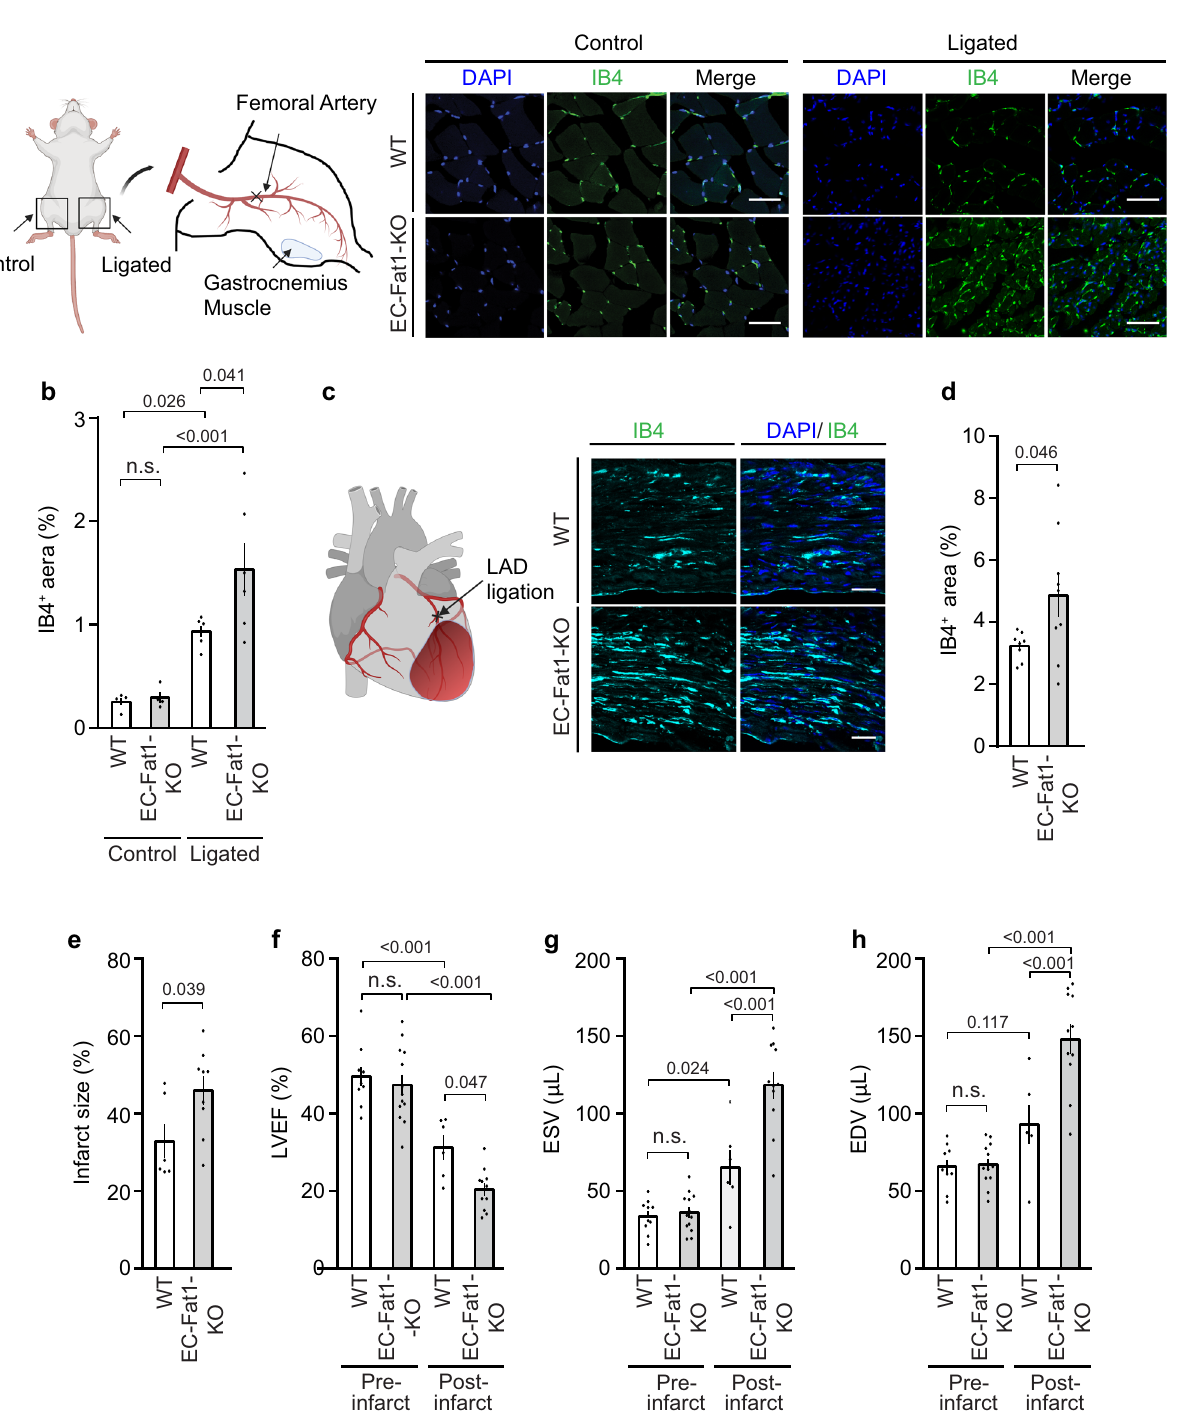
e Quanti fi cation of infarct size as determined by picrosirius red staining in hearts from control and EC-Fat1-KO mice after 14 days of acute myocardial infarction ( n =6 mice (WT); n =9 mice (EC-Fat1-KO)). f – h Heart function was analyzed by magnetic resonance imaging of control and EC-Fat1-KO mice before and 14 days afteracutemyocardialinfarction( n =10mice(WTpre-infarct); n =13mice(EC-Fat1- KOpre-infarct); n =6 mice(WTpost-infarct); n =11 mice(EC-Fat1-KO post-infarct)). Shown are the left ventricular ejection fraction (LVEF) ( f ), the end systolic volume (ESV) ( g ) and the end diastolic volume (EDV) ( h ). All values are mean±SEM. n.s. non-signi fi cant. Comparisons were performed using one-way ANOVA and Tukey ’ s post hoc test ( b , f – h ) or two-tailed unpaired t -test ( d , e ). Drawing displayed in ( a ) and ( c ) were created with